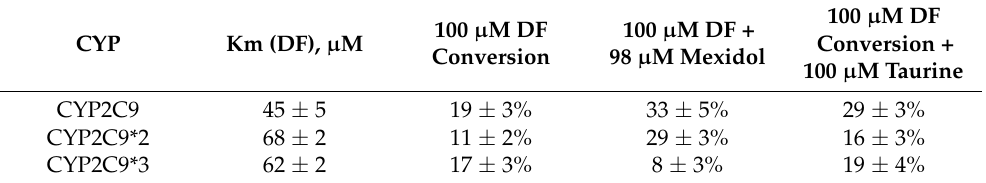
Table 3. Influence of the antioxidants mexidol and taurine on the electrocatalytic conversion of diclofenac catalyzed by cytochrome P450 2C9 and its allelic variants. 100 µ M DF 100 µ M DF 100 µ M DF + Conversion + CYP Km (DF), µ M Conversion 98 µ M Mexidol 100 µ M Taurine CYP2C9 45 ± 5 19 ± 3% 33 ± 5% 29 ± 3% CYP2C9*2 68 ± 2 11 ± 2% 29 ± 3% 16 ± 3% CYP2C9*3 62 ± 2 17 ± 3% 8 ± 3% 19 ±